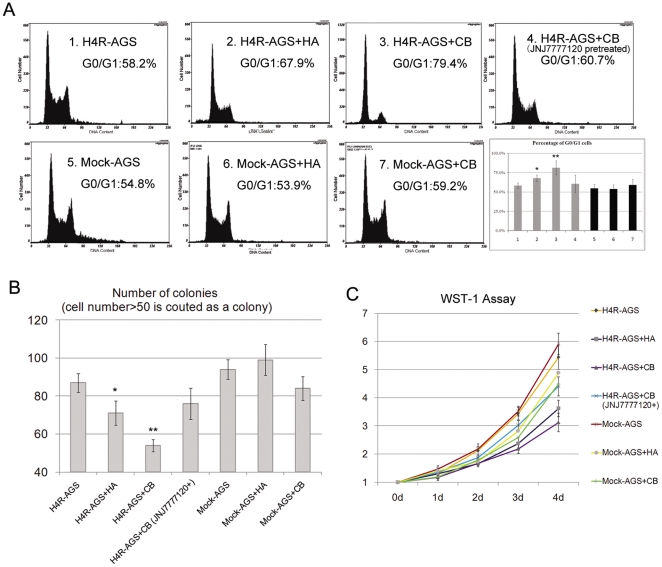
HRH4 activation induced growth arrest in gastric carcinoma cell lines.(A) Mock-AGS and H4R-AGS cells were treated with 10−5 M histamine, CB or CB accompanied by HRH4 antagonist (JNJ7777120) pretreatment, and cell-cycle distributions were determined by propidium iodide flow cytometry analysis. Each value is the mean±s.e. of triplicate data representative for three independent experiments. *p<0.05 and **p<0.01 vs. Control, H4R-AGS cells without any treatment. (B) Colony-formation assay. 5×103 Mock-AGS and H4R-AGS cells were treated as in Fig. 3A and maintained in G418 for 14 days, and the colonies were stained with Giemsa. The bar graph shows the absolute colony (≥50 cells) number±s.e. in duplicate experiments. *p<0.05 and **p<0.01 vs. Control, H4R-AGS cells without any treatment. (C) Mock-AGS and H4R-AGS cells were treated as in Fig. 3A, WST-1 (Roche) assay measuring the activity of mitochondrial dehydrogenases was performed following the manufacturer's instruction at 0-, 1-, 2-, 3- ,4- ,5- day time points. Each value is the means.e. of triplicate data representative for three independent experiments. Error bars represent standard deviation of the mean.